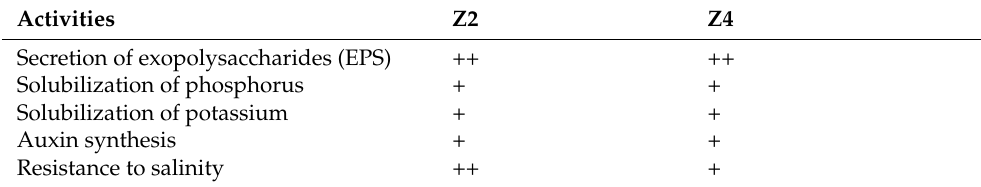
Table 1. Properties of the selected PGPR strains.